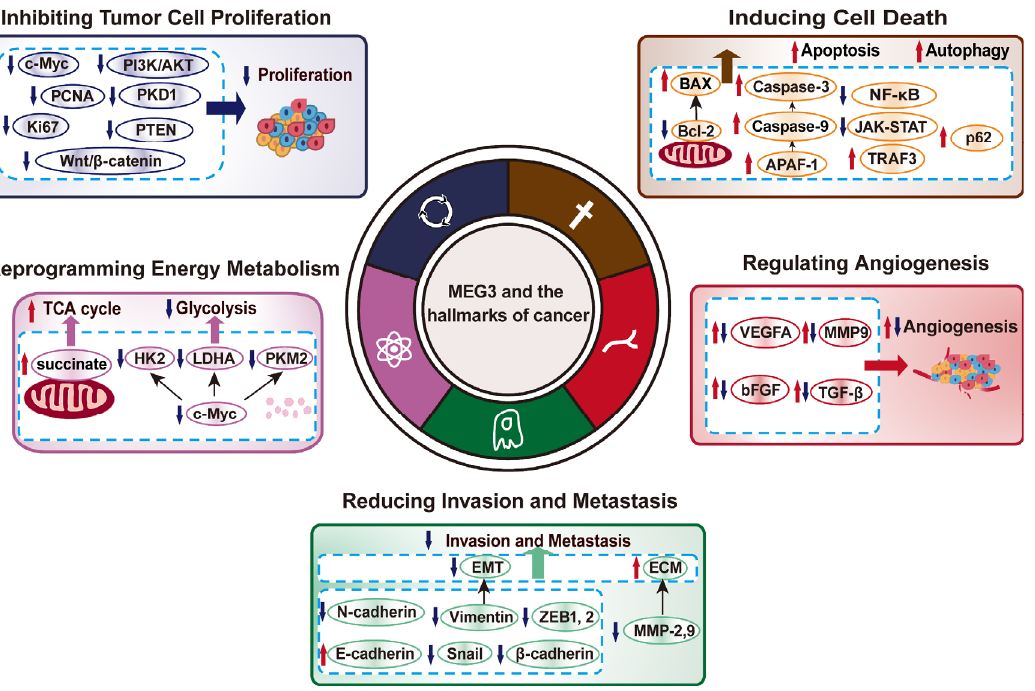
Figure 3. MEG3 and the hallmarks of cancer. In this review, we mainly focus on five hallmarks of cancer regulated by MEG3, including inhibiting tumor cell proliferation, inducing cell death, reduc- ing invasion and metastasis, reprogramming energy metabolism, and regulating